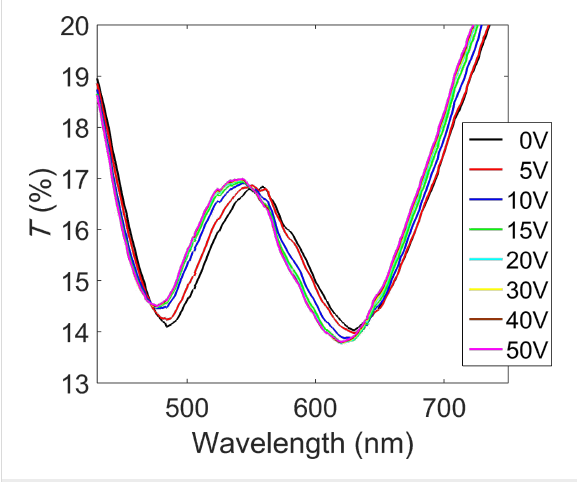
Figure 2: Transmission spectra of the ITO–(Ag nanoparticle/TiO 2 nanoparticle) 5 –ITO photonic crystal device upon application of an elec- tric field.